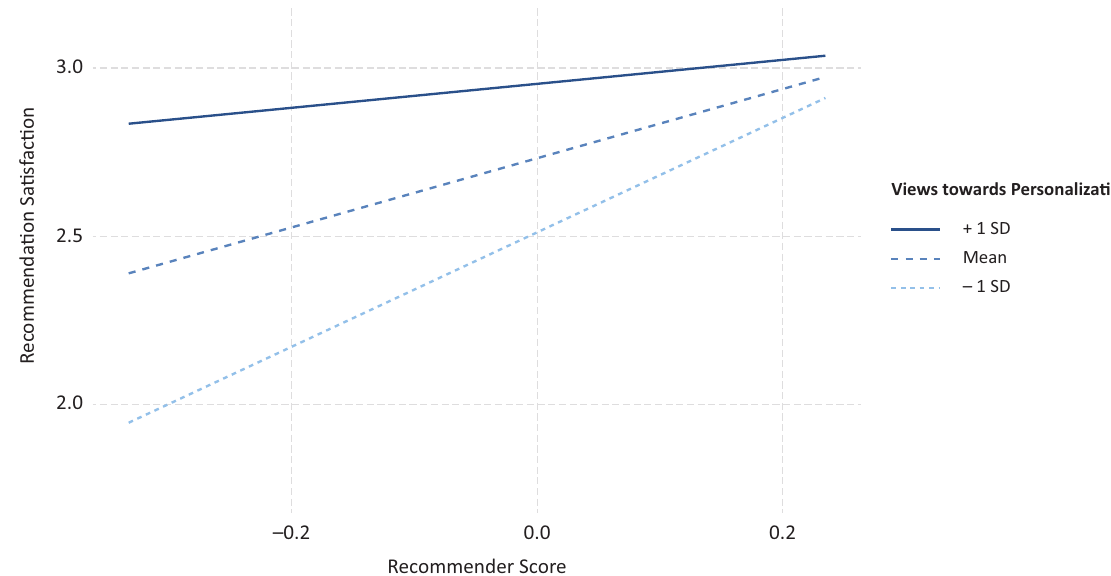
Figure 2. Moderating effect (n.s.) of view towards personalization on the conditional effect of text similarity on recommen‐ dation